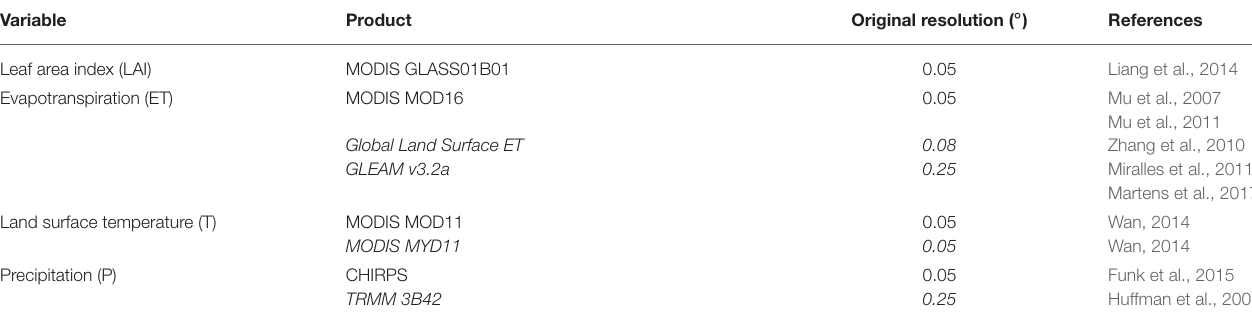
TABLE 2 | Details of the remote sensing observations used in this